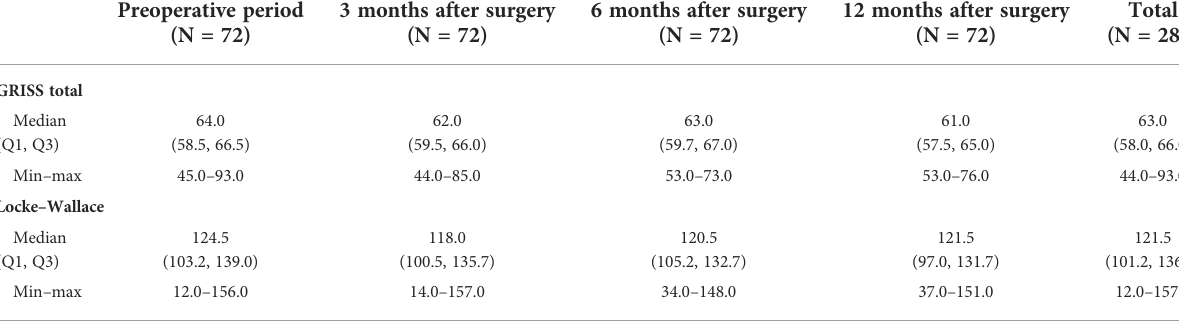
TABLE 2 Overall results for marital satisfaction and sexual quality of life.